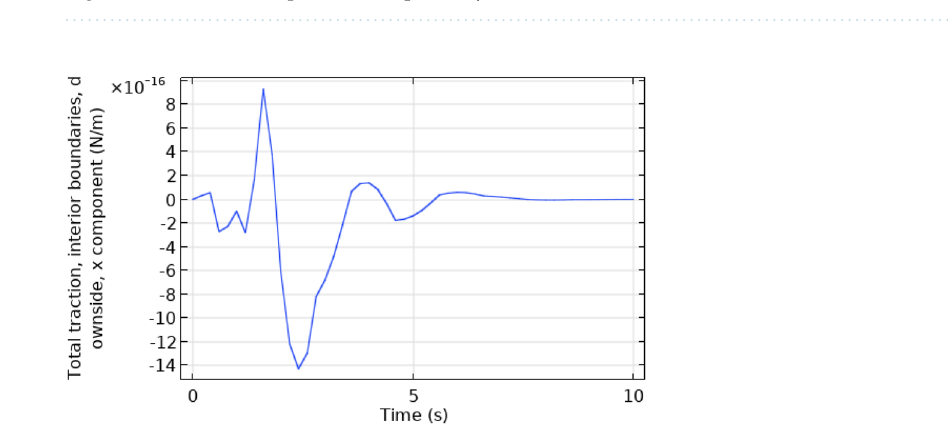
Figure 17. Contour temperature in squared cylindrical flow at t = 10 s.